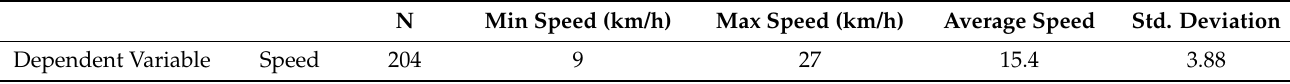
Table 5. Average speed and standard